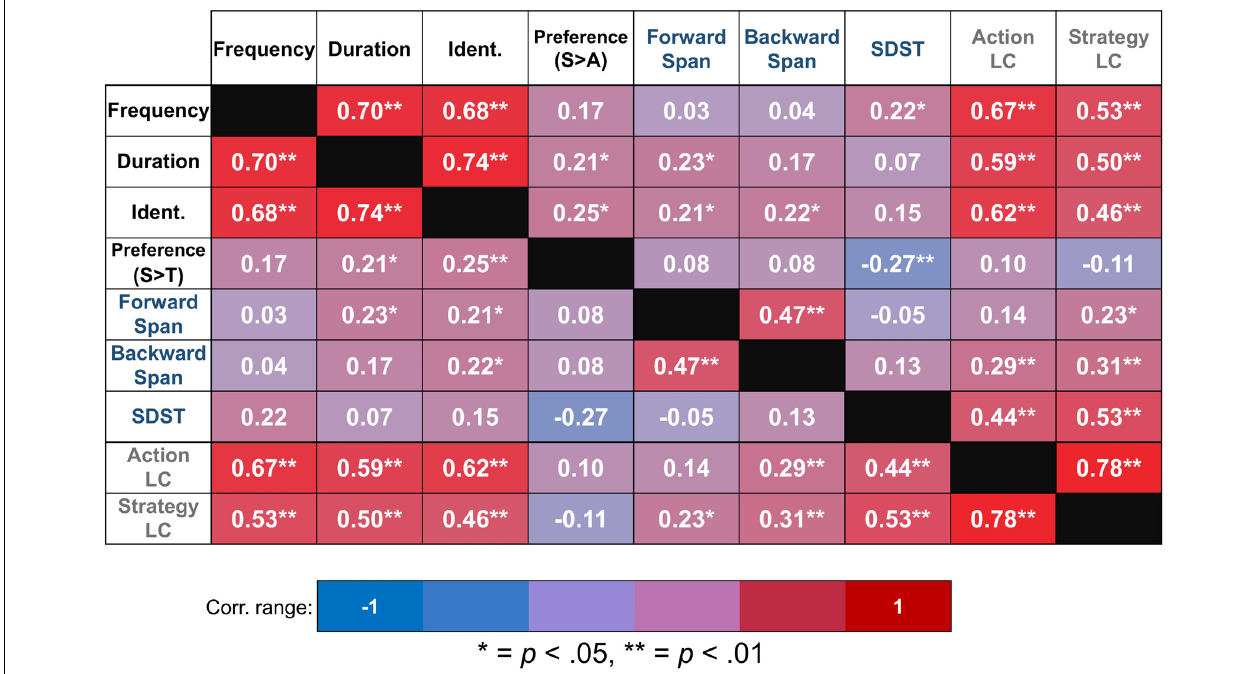
FIGURE 2 | Results of Pearson’s correlations between our variables of